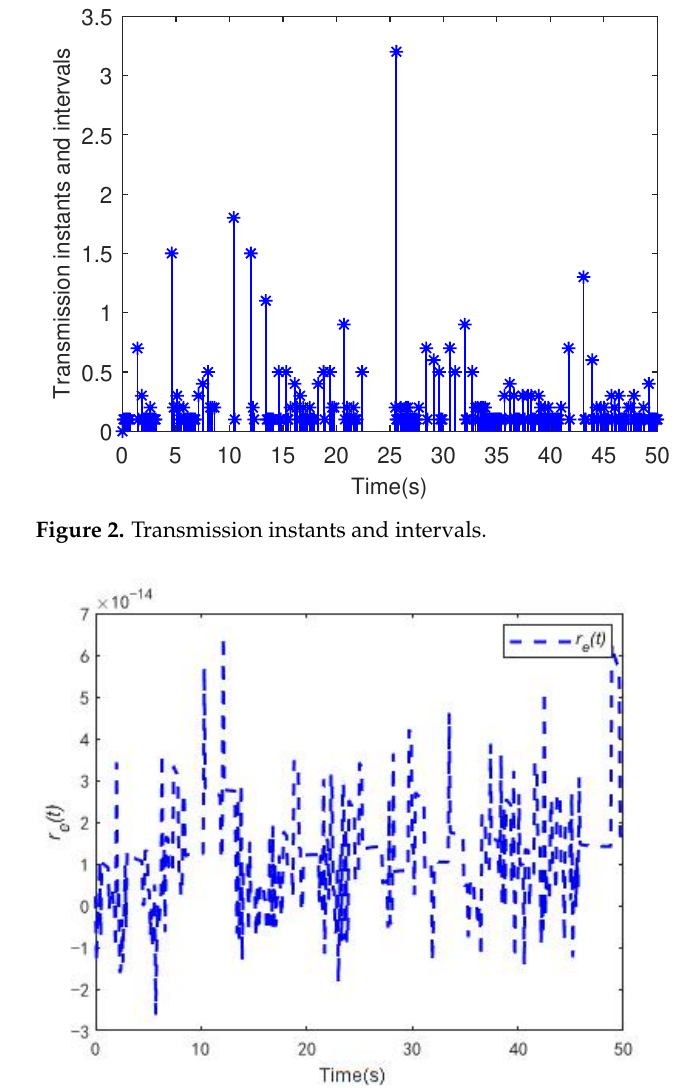
Figure 3. The trajectories of r e ( t ) without